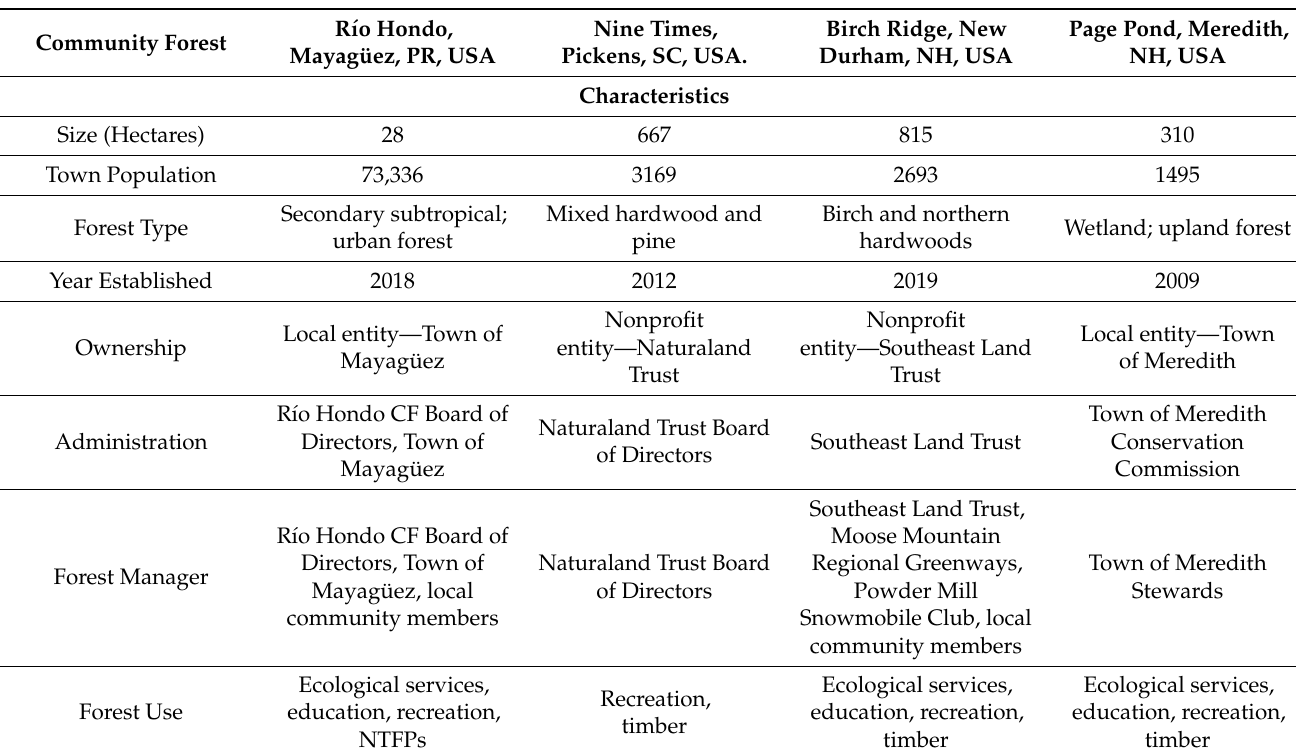
Table 1. Community Forest Case Study Sites